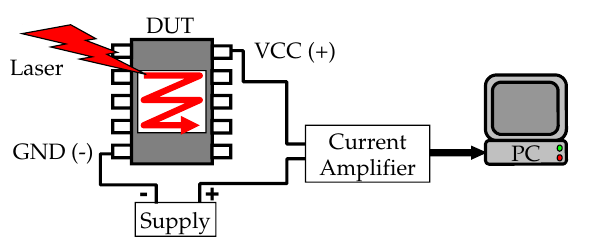
Figure 1: Supply current monitoring laser stimulation setup. Depending on the laser wavelength, thermal or photoelectric stimulation can be applied. Figure based on